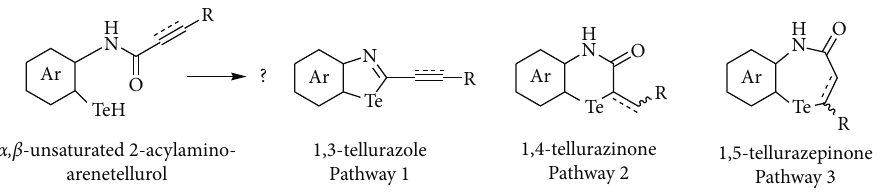
Figure 1: Potential pathways for the cyclization of arenetellurols carrying α , β -unsaturated amide functionalities in the ortho